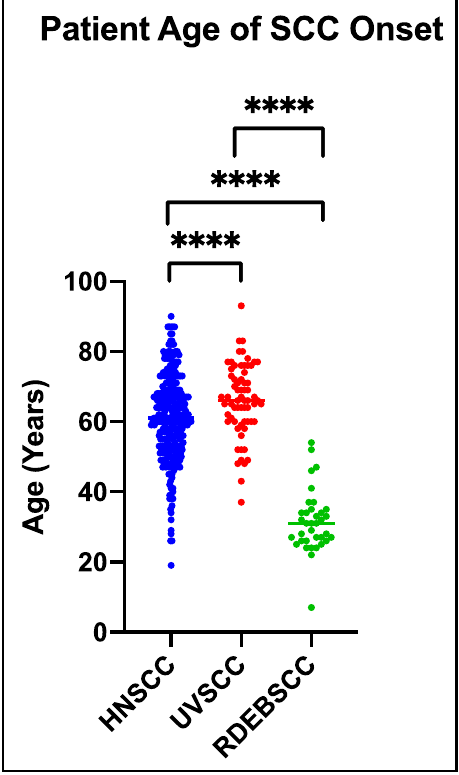
Figure 2. Age of Onset for SCCs in Different Populations. Head and Neck SCC (HNSCC) data [82], UV light-induced SCC (UVSCC) data [83,84], and RDEB SCC (RDEBSCC) data from our records of patient samples accumulated from 2005–2017. Data were plotted by GraphPad-Prism using a two-tailed, Mann–Whitney test assuming unequal variance. ****: p ≤ 0.0001. HNSCC: n = 278; UVSCC: n = 66; RDEBSCC: n = 36.